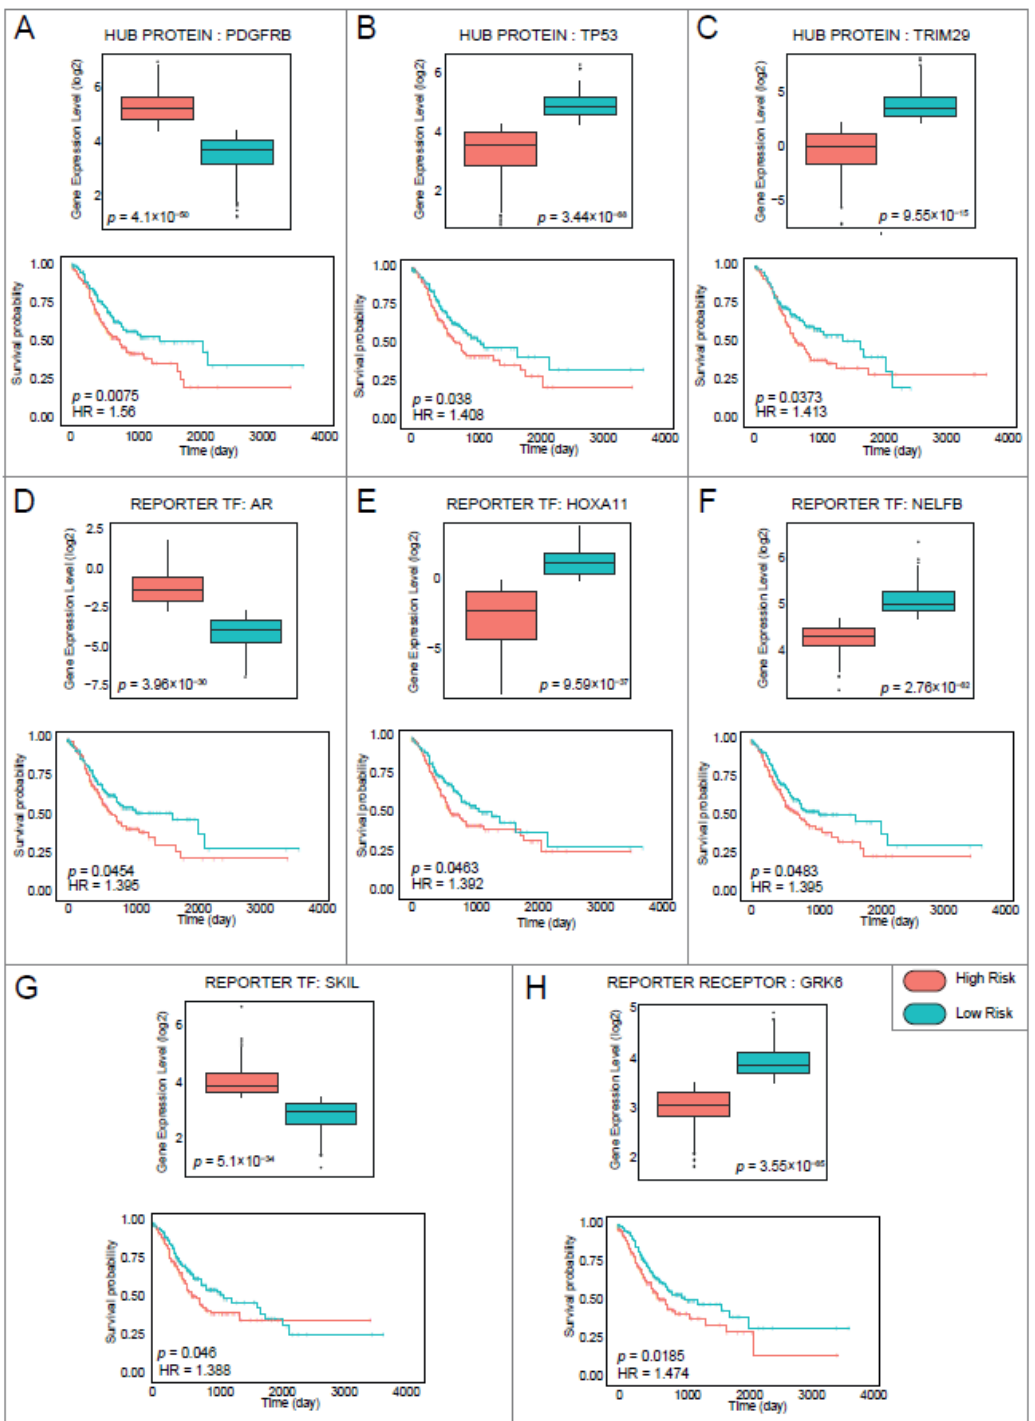
Figure 5. Analysis of prognostic performance of reporter biomolecules. Box plots showing expression levels of reporter biomolecules between low and high-risk groups with p -values. Kaplan–Meier plots estimating survival of patients with gastric cancer showing p -value and hazard ratio for each curve. ( A ) Hub protein: PDGFRB. ( B ) Hub protein: TP53. ( C ) Hub protein: TRIM29. ( D ) Reporter transcription factor (TF): AR. ( E ) Reporter TF: HOXA11. ( F ) Reporter TF: NELFB. ( G ) Reporter TF: SKIL. ( H ) Reporter receptor: GRK6. The high-risk group was shown in red, while the low-risk group was shown in